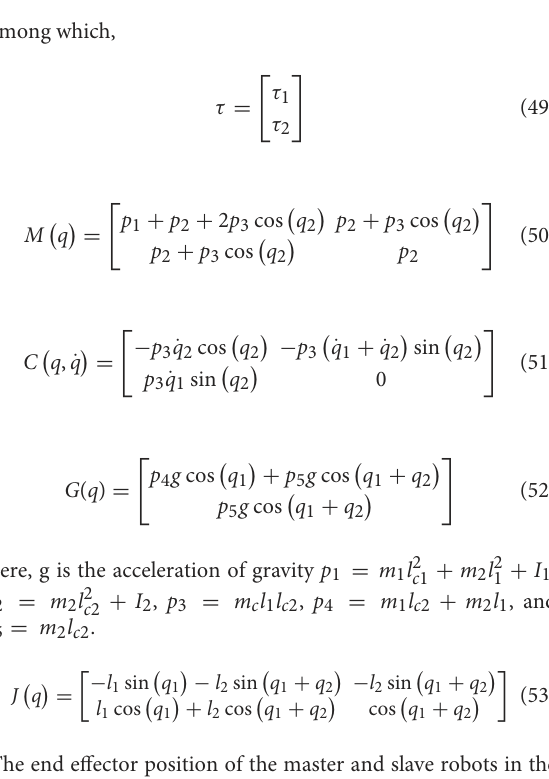
FIGURE3 Schematic diagram of teleoperation system selected by simulation.